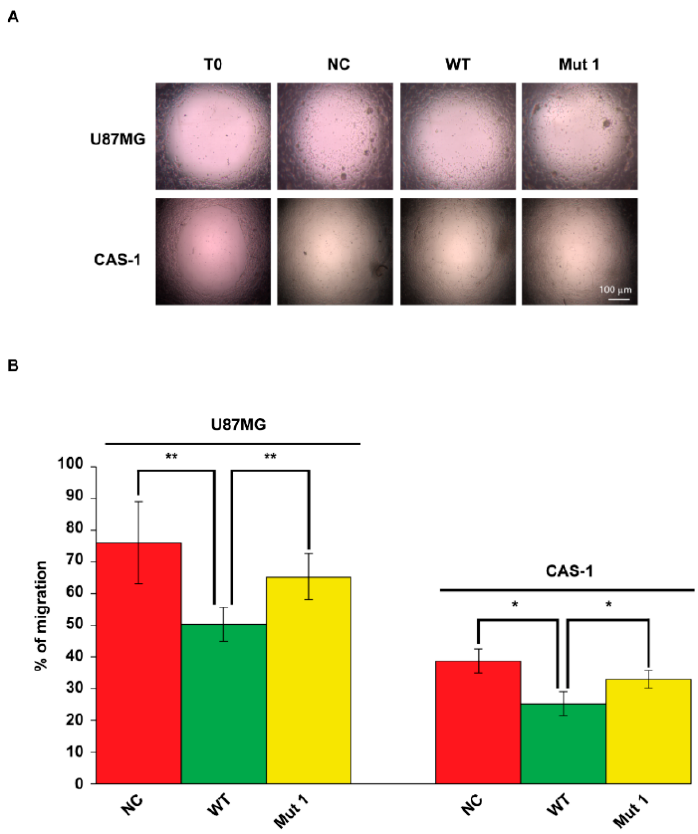
Figure 3. U87MG and CAS-1 transfected with Mut1 circSMARCA5 migrate significantly more than